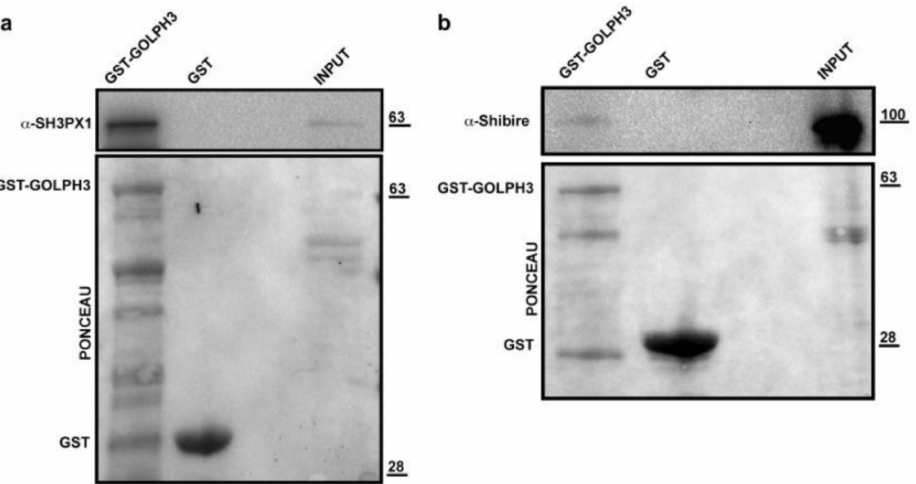
Figure 5. dGOLPH3 interacts with endocytic trafficking proteins. GST (control) and recombi- nant GST-GOLPH3 proteins, immobilized on Gluthatione-Sepharose beads were incubated with testis protein extracts from Oregon-R males. Ponceau staining is shown as a loading control. 2% of the input and 25% of the pull-down were loaded and probed for SH3PX1 ( a ) and Shibire ( b ). Molecular masses are expressed in